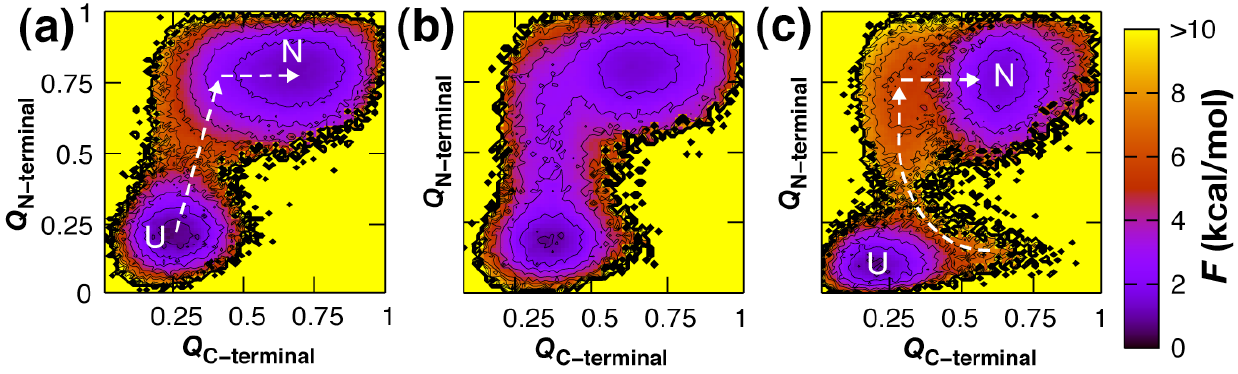
Figure 1. N-terminally nucleated folding landscapes for structural homologs CheY (a), NtrC (b) and Spo0F (c). The equilibrium free energy was computed as a function of the fraction of native contacts formed within the N- ( Q subdomains and is shown at the transition temperature at which the folded and unfolded states are equally populated